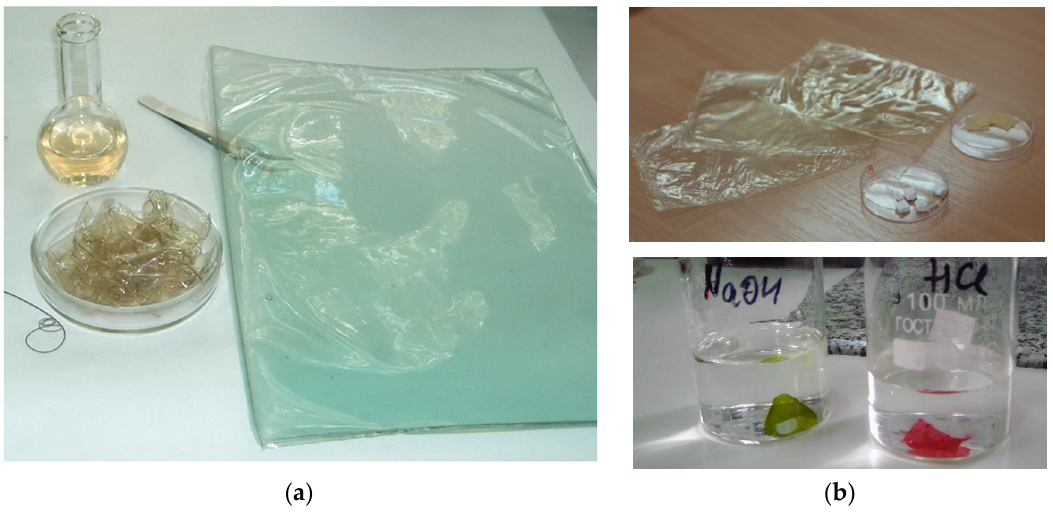
Figure 2. Films based on chitosan: ( а ) experimental sample of the film made from chitosan; ( b ) smart film ( Open source photos ) [51].